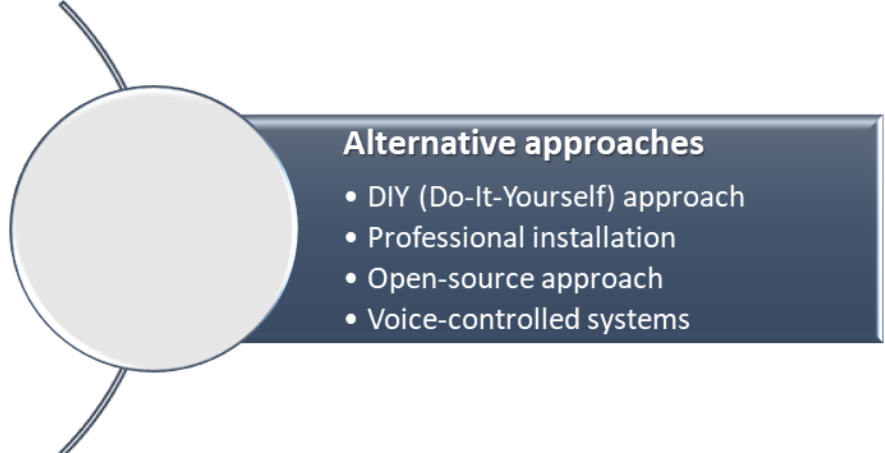
Figure 7. Alternative approaches within a smart home system.